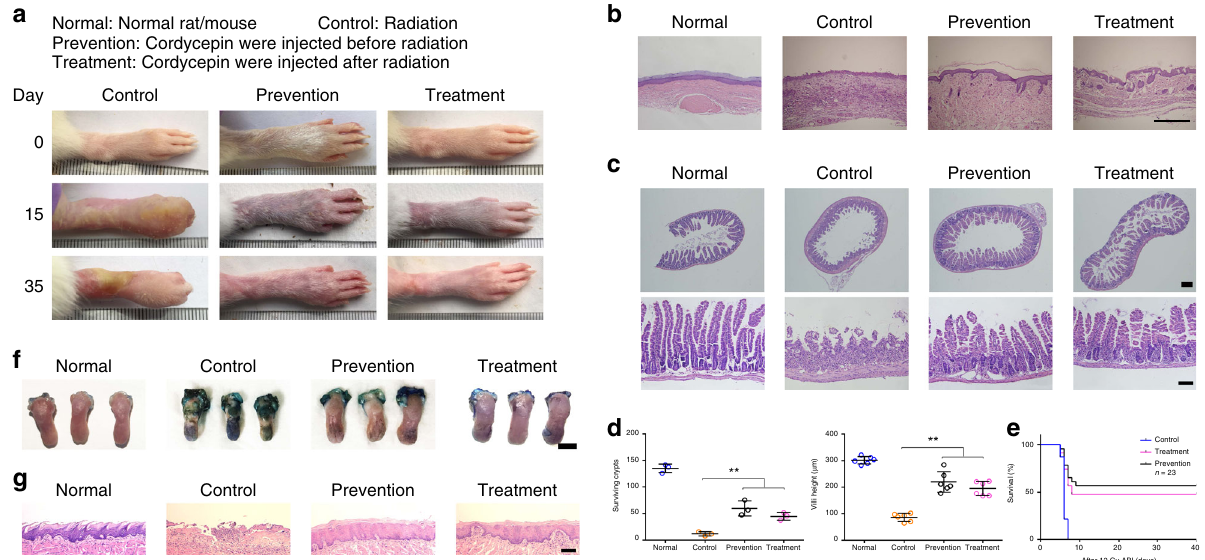
Fig. 3 Cordycepin prevents radiation ulcer. a Images of hind limb from irradiated rats (control, prevention, treatment) on day 0, 15, and 35. This test was repeated three times. Representative images were shown. Control: Rat right posterior limb (other parts covered with lead board) was exposed to 40 Gy radiation under anesthesia; Prevention: Cordycepin were injected before radiation; Treatment: Cordycepin were injected after radiation. b Histological analysis of the skins from normal rats and irradiated rats (control, prevention, treatment) 35 days after radiation. c Histological analysis of intestinal sections from normal mice and irradiated mice (control, prevention, treatment) 4 days after radiation. This test was repeated three times. Representative images were shown. Control: Mouse abdominal (other parts covered with lead board) was exposed to 12 Gy radiation under anesthesia. Prevention: Cordycepin were injected before radiation; Treatment: Cordycepin were injected after radiation. d Quantitation of surviving crypts ( n = 3) and villus height ( n = 6) from normal mice and irradiated mice (control, prevention, treatment) 4 days after radiation, the villus height was calculated using Image J software. e Survival curve of mice subjected to abdominal radiation ( n = 23). f Representative pictures of tongues stained with toluidine blue from normal mice and irradiated mice (control, prevention, treatment) 10 days after radiation. Lack of protective epithelial barrier and therefore ulcer formation is indicated by deep, royal blue staining in epithelium defects. This test was repeated three times. Representative images were shown. Control: Mouse head and neck area (other parts covered with lead board) was exposed to 15 Gy radiation under anesthesia. Prevention: Cordycepin were injected before radiation; Treatment: Cordycepin were injected after radiation. g Histological analysis of the tongues from normal mice and irradiated mice (control, e represent the means ± S.D. (** P < 0.01; student ’ s t